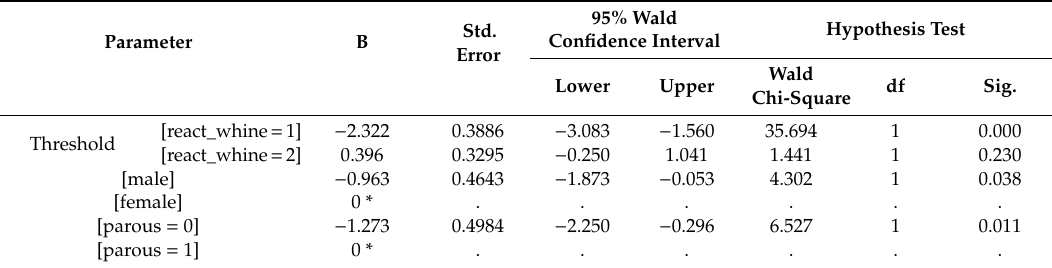
Table 4. Parameter estimates of adult dogs’ reaction to the whining of puppies, as a function of their sex and parousness (0 = did not have puppies; 1 = had puppies). GzLM with ordinal logistic. * this parameter is set to 0 because it is